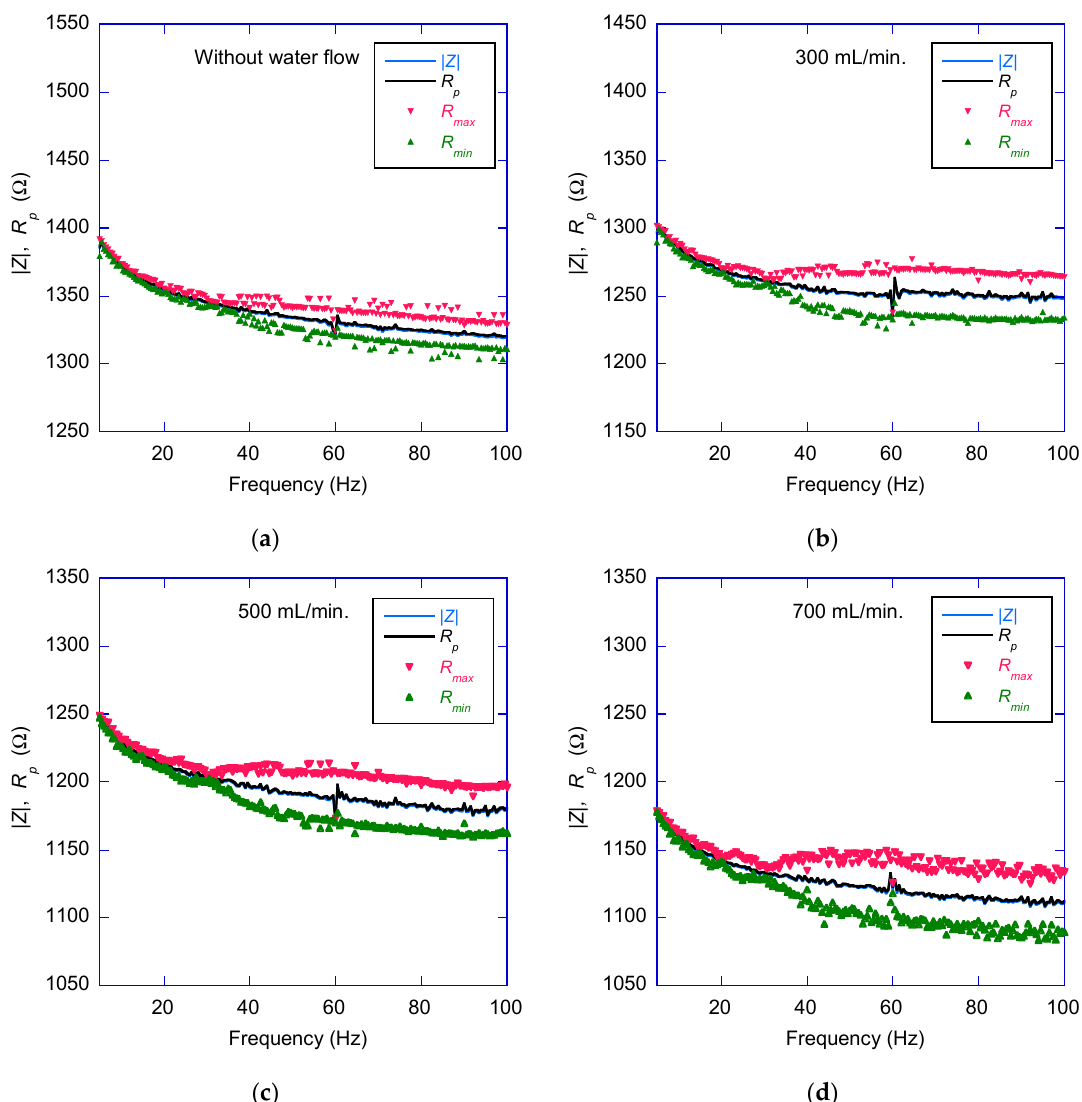
Figure 6. Apparent soil impedance | Z | , resistance R p and max. and min. of R p : ( a ) without water flow; ( b ) water flow of 300 mL/min; ( c ) water flow of 500 mL/min; ( d ) water flow of 700 mL/min.